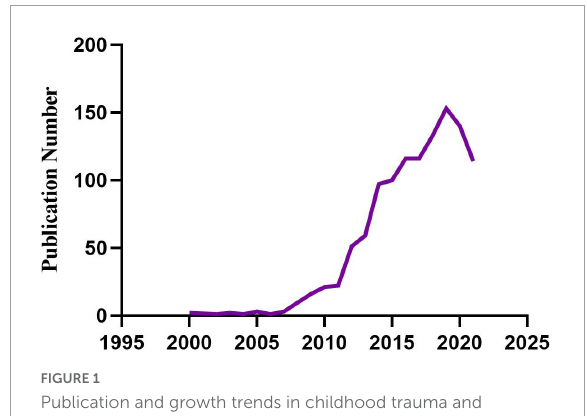
FIGURE1 Publication and growth trends in childhood trauma and